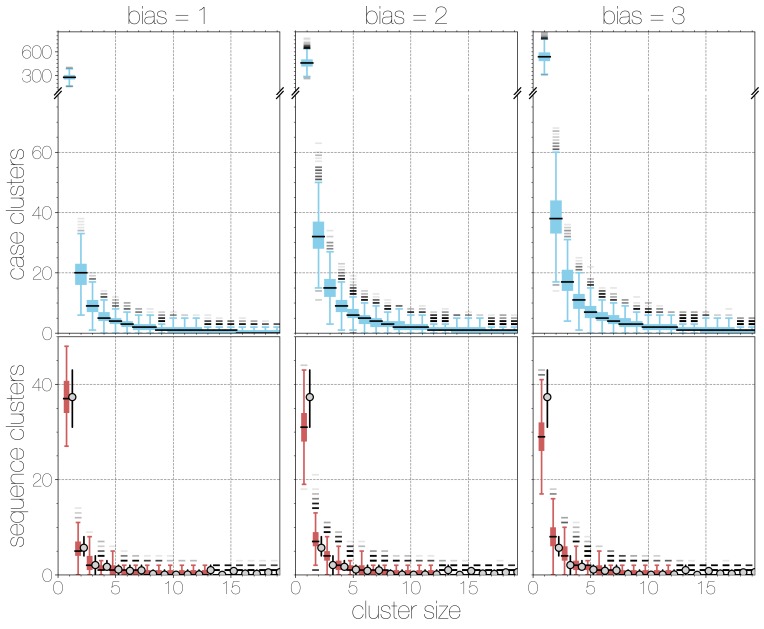
Boxplots of matching simulated case and sequence cluster distributions.Boxplots indicate frequency of case (blue, top) and sequence (red, bottom) cluster sizes across simulations at different bias levels, marginalised across R0 values. Outliers are shown with transparency, medians are indicated with thick black lines. Case clusters exhibit a strong skew with large numbers of singleton introductions and a substantial tail at higher levels of bias.